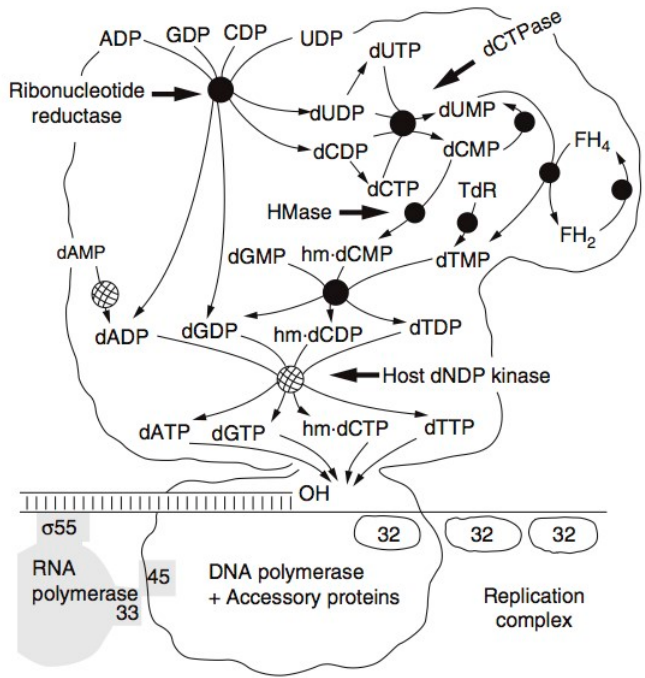
Figure 4. T4 DNA Replication Complex: The tight T4 complex of the enzymes responsible for nucleotide biosynthesis, DNA replication and late gene transcription. As host transcription is shut off, most of the ribonucleoside diphosphates are quickly channeled into producing a set of DNA precursor pools, in the process making hydroxymethyl deoxycytidine triphosphate (HMdCTP) rather than deoxycytidine triphosphate (dCTP). They flow in tightly linked fashion through the complex to the DNA polymerase, sustaining T4’s extremely rapid and efficient DNA replication.